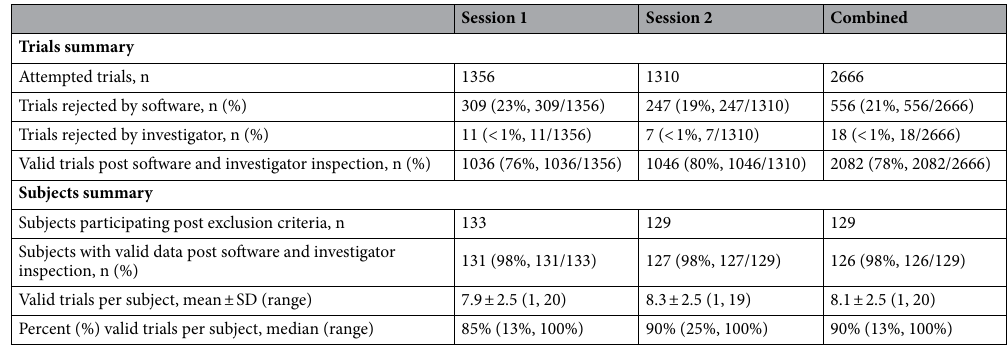
Table 1. Trial characteristics across study sessions. SD 1 standard